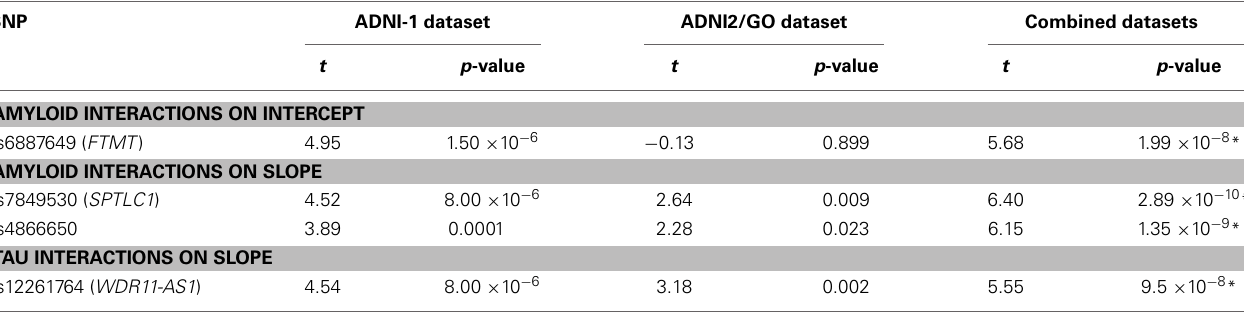
Table 2 | SNP interaction results. SNP ADNI-1 dataset ADNI2/GO